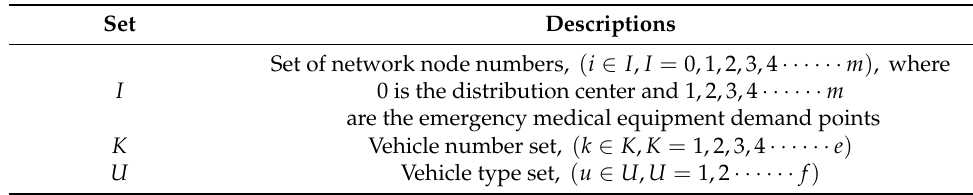
Table 1. Set symbols and descriptions. Set